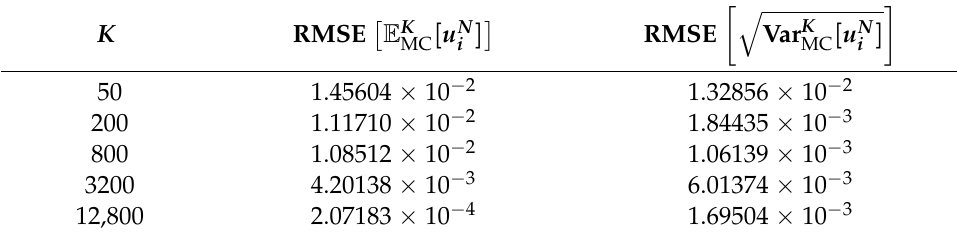
Table 1. Root mean square errors (RMSEs) at T = Nk = 1 with k = 0.0001 ( N 0 = 1000) for the numerical expectation and the numerical standard deviation computed after solving the K -deterministic difference scheme (18) for several Monte Carlo (MC) realizations K ∈ {50, 200, 800, 3200, 12,800}. The spatial discretization have been considered on the domain [ 0 + h = 0.0125,1 − h = 0.9875 ] with x i = ih , 1 ≤ i ≤ 79, h =